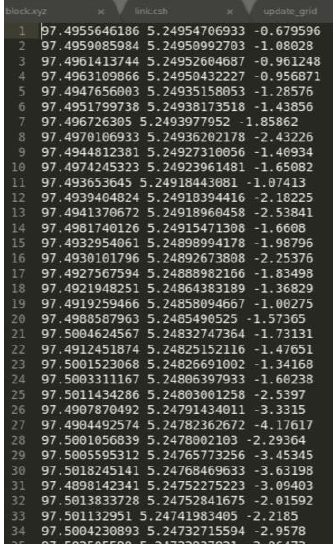
Figure 7. Height differences after corrected with threshold parameter (column